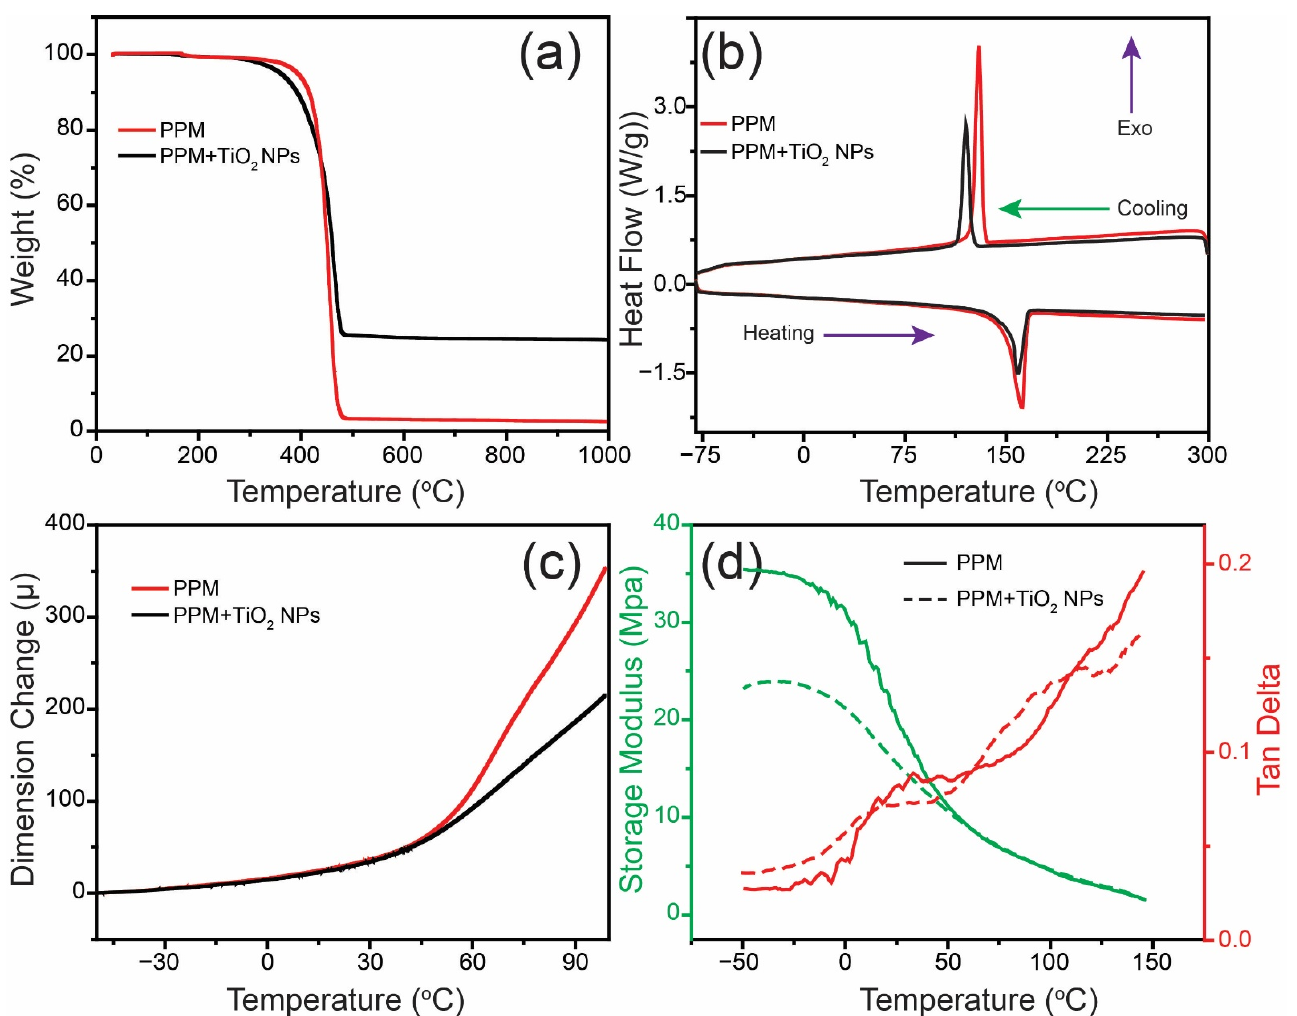
2 NPs: ( a ) TGA, ( b ) DSC, ( c ) TMA, and